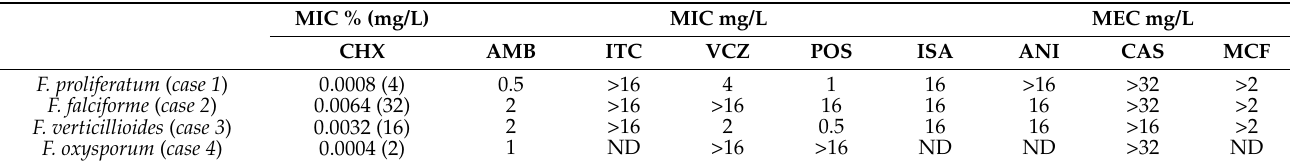
Table 2. In vitro activity of eight antifungal agents and chlorhexidine digluconate against the Fusarium strains of the described fungal keratitis